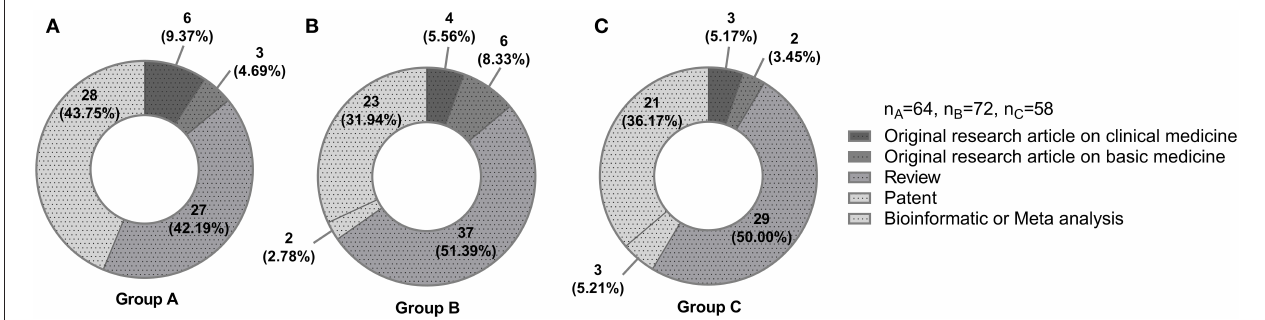
FIGURE 3 | The most published types of articles by students. (A) Group A, single tutor for multiple students’ system. (B) Group B, multiple tutors for multiple students’ system. (C) Group C, no tutor